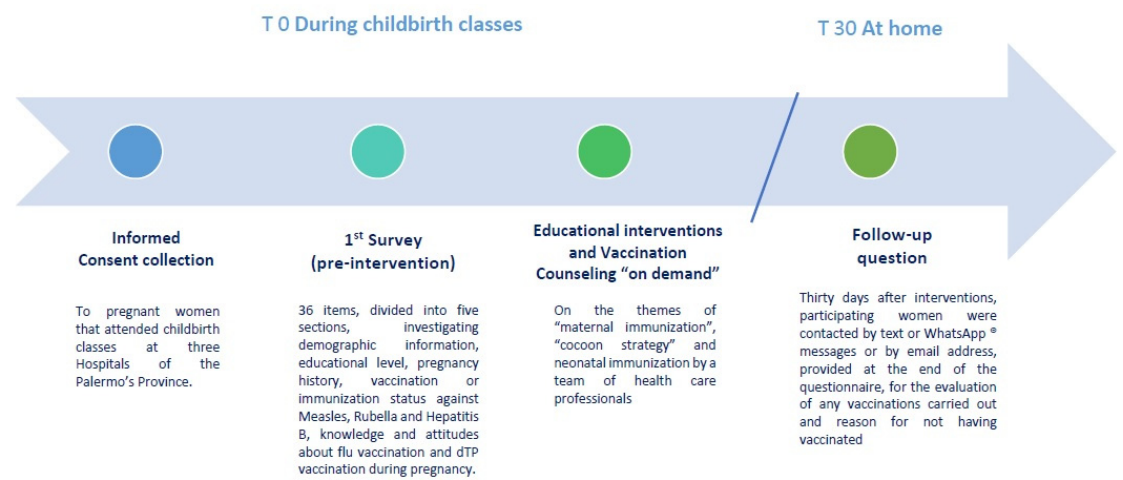
Figure 1. Timeline of the study design at T0 (during childbirth classes) and at T30 (pregnant women participating from home).